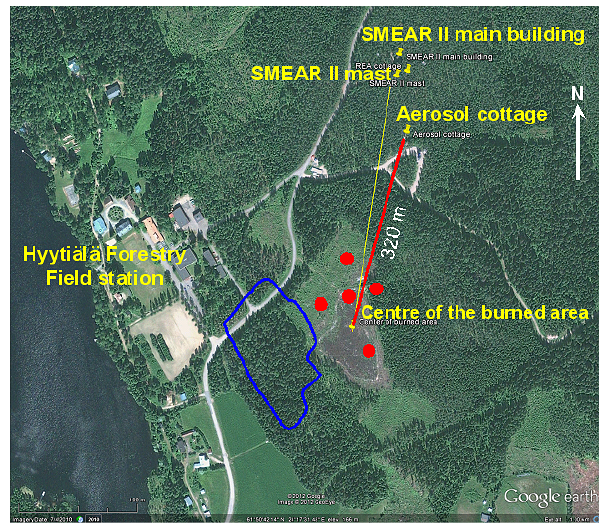
Figure 1. Location of the burned area (in grey), the SMEAR II main building, mast, and aerosol cottage (yellow pins), and the meteoro- logical measurements within and around the burning area (red dots). The distance from the centre of the burned area to the aerosol cot- tage is 320m. The blue line encircles a non-burned reference area. This Google Earth satellite image was taken on 4 July 2010, ap- proximately a year after the